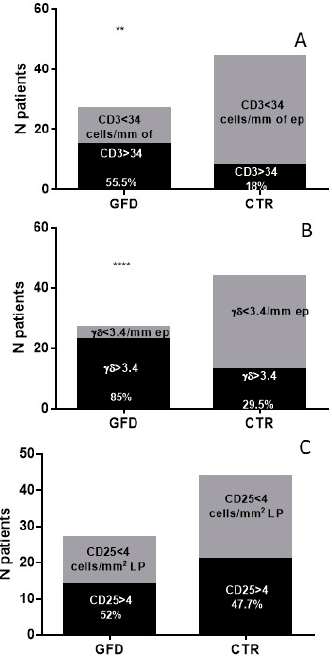
5 of 9 Figure 2. Immunohistochemical parameters in different patients group. ( A ) CD3+ cells/mm of intes- tinal epithelium. ( B ) TCR γδ + cells/mm of intestinal epithelium. ( C ) CD25+ cells/mm 2 of intestinal lamina propria. Grey dots represent patients on a gluten free diet with a persistently positive CD- serology. Dashed horizontal line represents cut-off limits of normality for each immunohistochem-